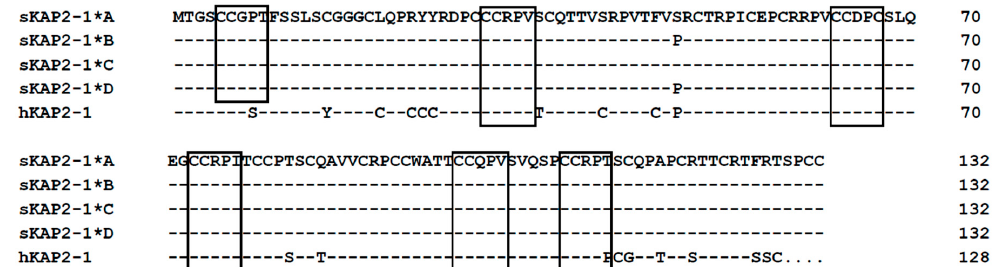
Figure 5. Alignment of the predicted amino acid sequences derived from keratin-associated protein 2-1 gene from sheep, and the human protein sequence. Dashes are used to indicate the same amino acids as the top sequence, while dots have been introduced to improve the alignment. The sheep and human sequences are indicated with the prefix “s” and “h”, respectively, and KAP2-1 represents the keratin-associated protein 2-1. The cysteine-containing pentameric repeat structures are boxed. 3.4. Frequencies of the Keratin-Associated Protein 2-1 Gene Variants in Four Chinese Sheep Breeds The frequencies of the ovine keratin-associated protein 2-1 gene variants in the 216 sheep are listed in Table 1. Variant C was the most common in all of the four breeds investigated, with a frequency ranging from 55.3% in the Chinese Merino sheep to 79.0% in the Tibetan sheep. In the Tibetan sheep and the Kazakh sheep, B was the second most common variant (with a frequency of 15.3% and 16.0%, respectively), and variants A and D were found to be the least common. However, in the Chinese Merino and Gansu Alpine Fine-wool sheep, B was the least common variant and the second most common variant was A (with a frequency of 19.7% and 22.7% in the Chinese Merino and the Gansu Alpine Fine-wool sheep, respectively).